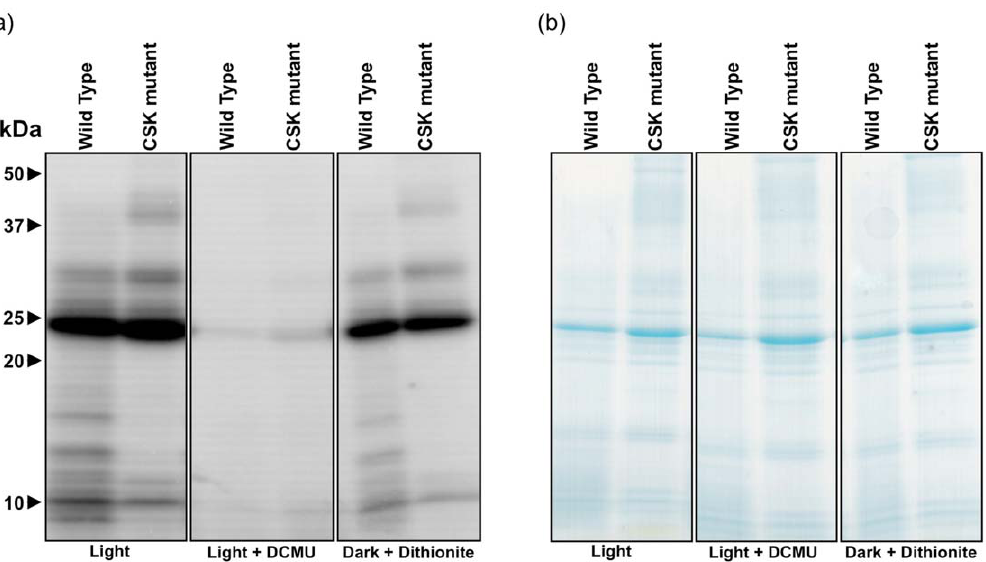
Figure 3. CSK mutants show normal LHC II phosphorylation. (a) Autoradiographs of Arabidopsis thylakoid phosphoproteins separated by SDS-PAGE. The positions of molecular weight markers are indicated on the left. Thylakoid samples from the wild-type (WT) and the CSK mutant are loaded in each lane and labelled accordingly at the top. The experimental conditions for each pair of samples are labelled at the bottom. (b) Coomassie-stained gel as protein loading control. The gel from which the autoradiograph was developed is stained with Coomassie brilliant blue to show that results presented in (a) results from 32 P-labelling and not from unequal protein loading.